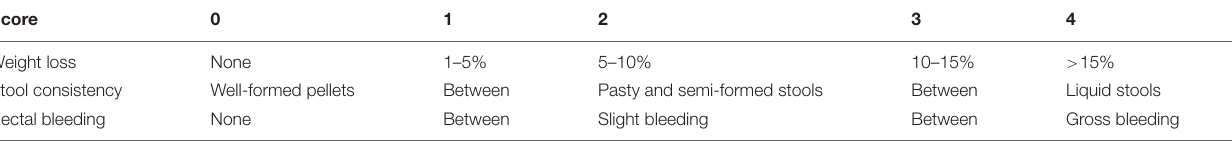
TABLE 1 | The criteria for scoring DSS-induced